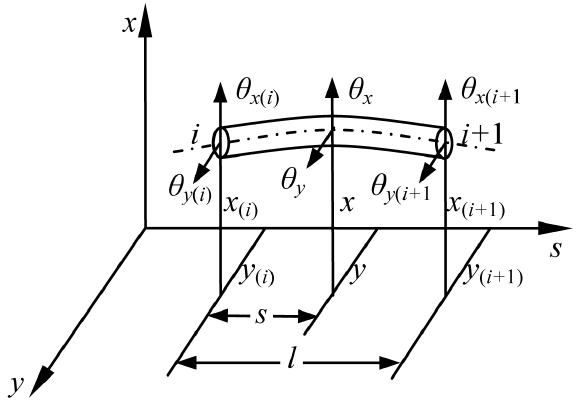
Fig. 2. A shaft finite